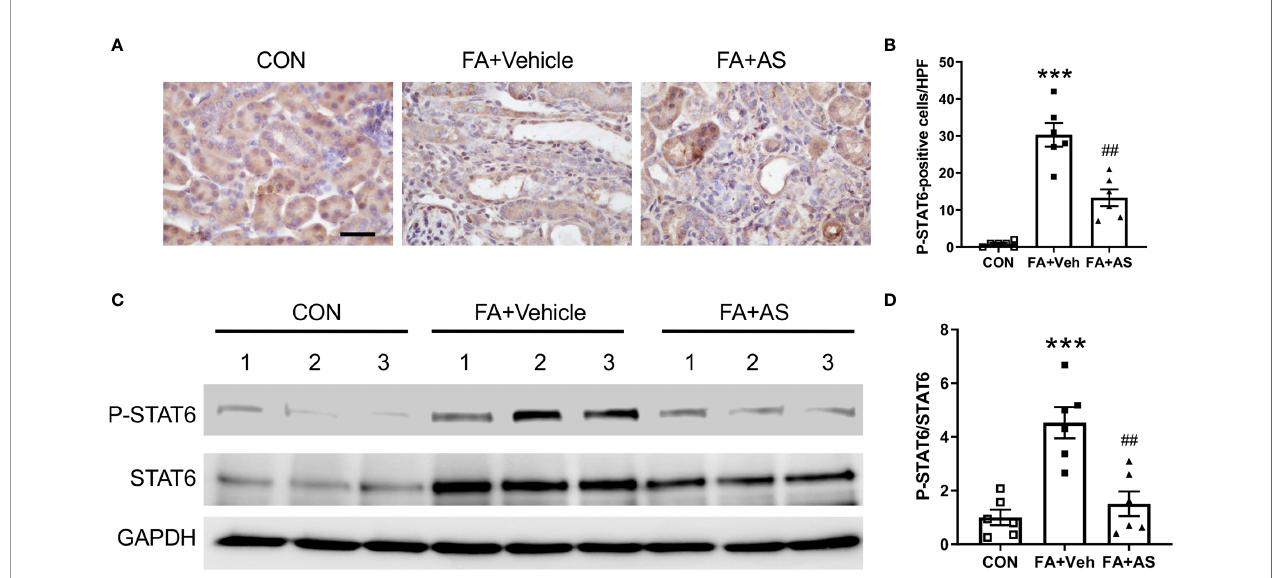
FIGURE 5 | AS1517499 inhibits STAT6 activation in folic acid nephropathy. (A) Representative images of immunohistochemical staining of phosphorylated STAT6 in the kidney 2 weeks after vehicle or AS1517499 treatment. Scale bar, 50 m m. (B) Quantitative analysis of phosphorylated STAT6-positive cells in the kidney 2 weeks after vehicle or AS1517499 treatment. *** P < 0.001 vs . CON; ## P < 0.01 vs FA+Veh. n = 6 per group. (C) Representative Western blot of p-STAT6 and STAT6 in the kidney. (D) Quantitative analysis p-STAT6 protein levels in the kidney. *** P < 0.001 vs . CON; ## P < 0.01 vs FA+Veh. n = 6 per